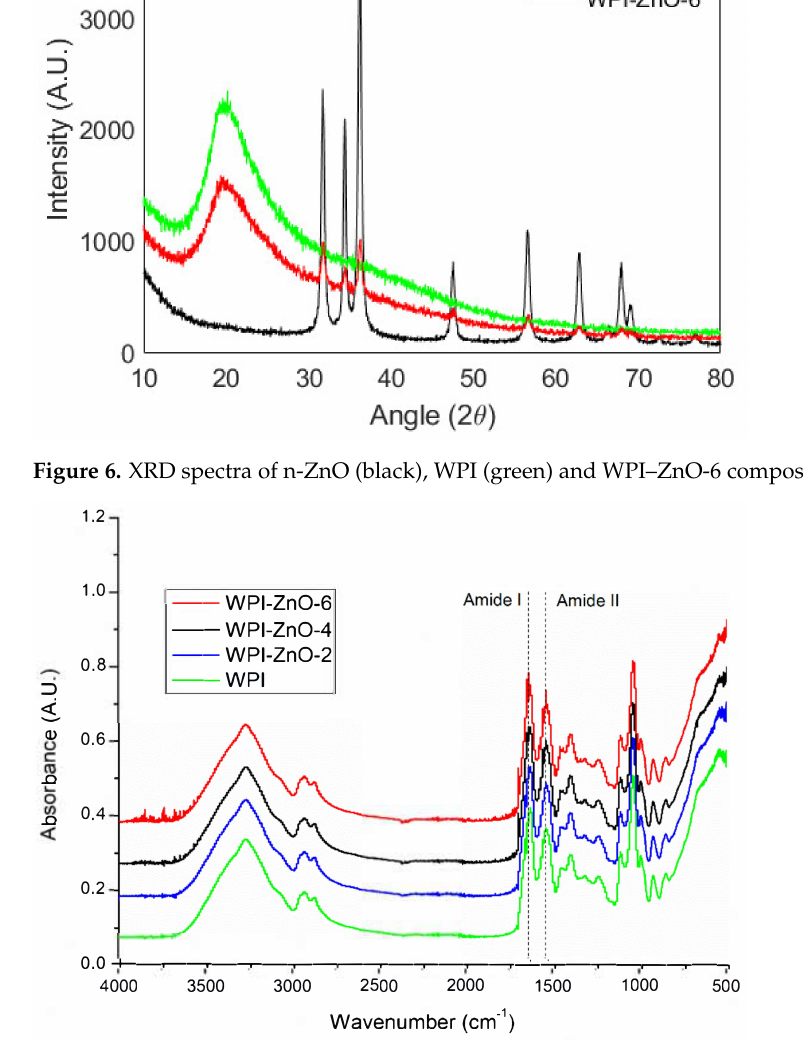
Figure 7. ATR-FTIR Spectra of WPI and WPI–ZnO